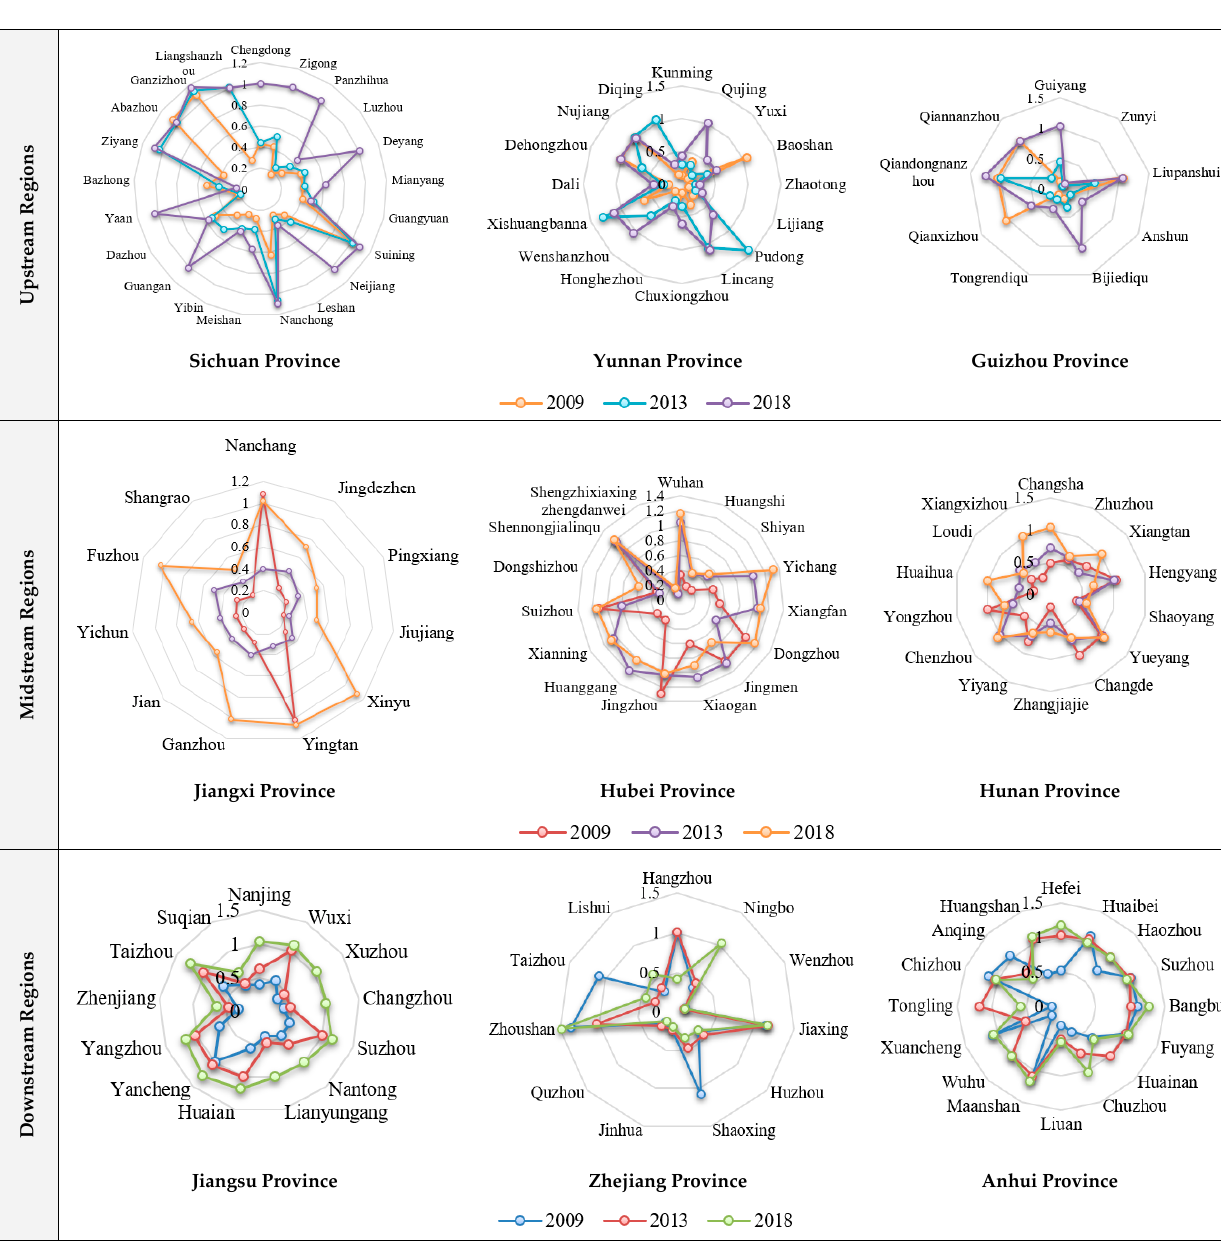
Figure 6. Eco-efficiency of agricultural land in each province.